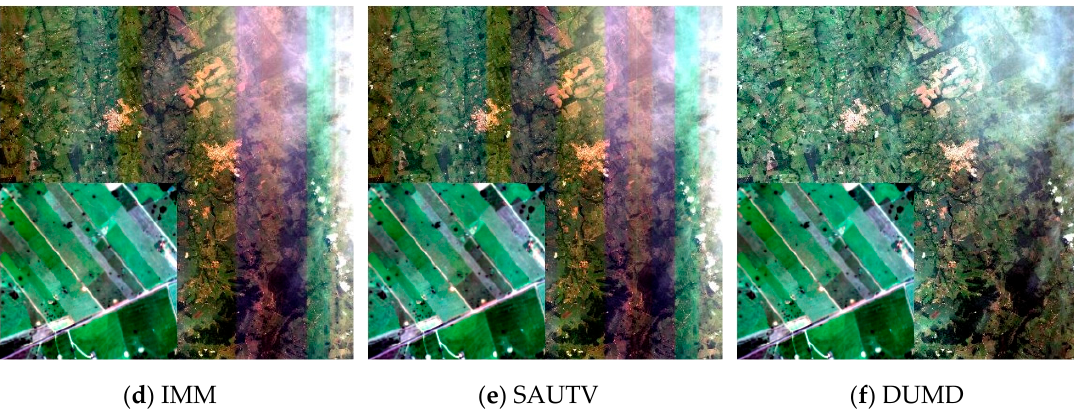
Figure 3. Destriping performance of Data 3 (Gaofen-1C, GF-1C). MM, moment matching; IMM, improved MM; SAUTV, spatially adaptive unidirectional total variation. Where ( a ) is the no-stripe image, ( b ) is the striped image, ( c ) is the destriped image processed by MM, ( d ) is the destriped image processed by IMM, ( e ) is the destriped image processed by SAUTV, ( f ) is the destriped image processed by DUMD.